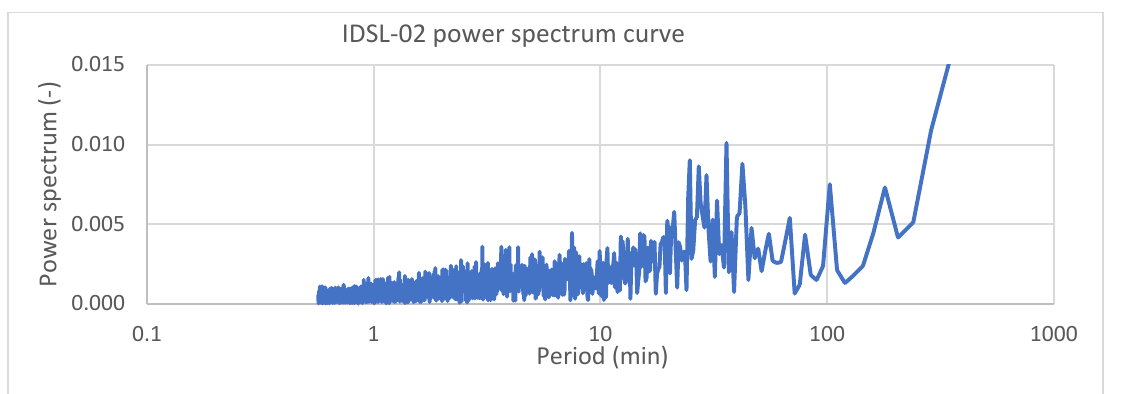
Figure 5 . Sea level measured in Saidia, Morocco.